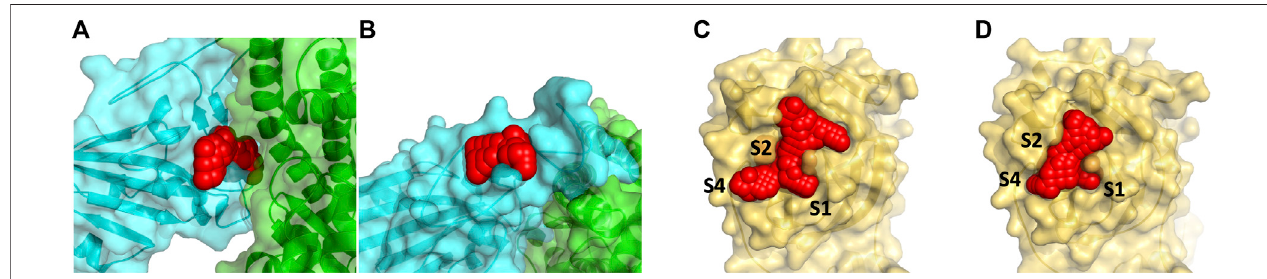
FIGURE 1 | Panel (A) shows the docking site on the RBD of the spike protein in red (by residues 501 – 505) that are at the interface with ACE2 (show in green) and denoted spike1 in the text. A smaller secondary binding site (denoted spike2) in the spike protein in receptor binding motif domain was detected and used for docking studies (B) .Panel (C) and (D) showthebindingsiteoftheM pro withtheN3inhibitorremoved(6LU7)isprotease1andtheapoprotein(6Y84)isprotease2.TheS2binding pocket is below the sidechains of Met49 and Gln189 and is not visible in the